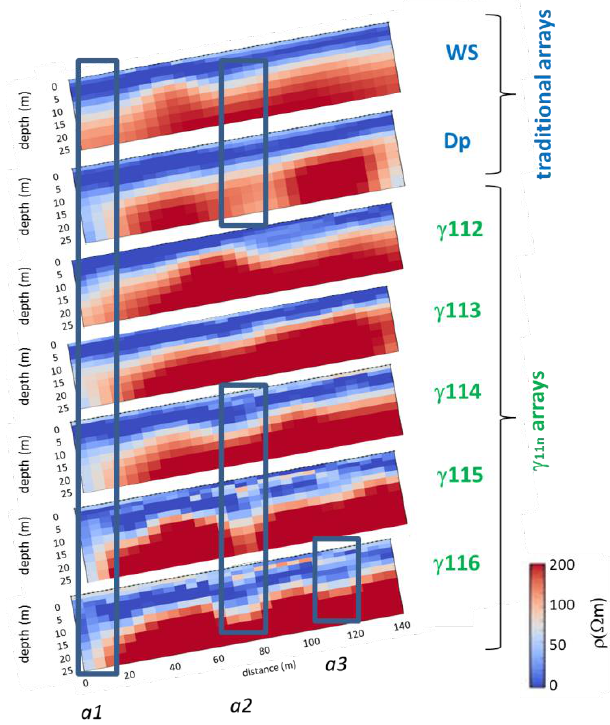
Figure 5. Study of a series of faults (Section 3.1.1) using different geoelectric arrays: ERT images above a series of faults. Rectangles horizontally delineate the supposed fault fracture zones. a1–3 denotes the anomaly zones.